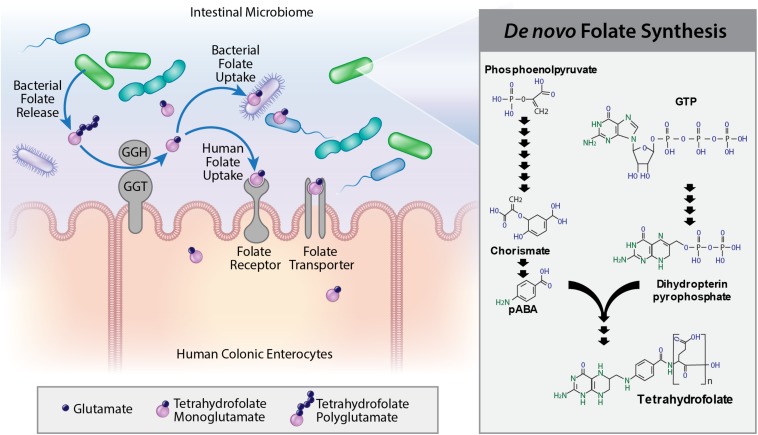
Model of microbial folate production and microbe:host interactions. Polyglutamylated tetrahydrofolates are synthesized by the human intestinal microbiome. Human gamma-glutamylhydrolase, GGH, and gamma-glutamyltransferase, GGT, remove glutamate moieties making monoglutamylated folates available for uptake by other luminal bacteria or human colonocytes. Folate can activate folate receptors (Frα or Frβ) or be taken up into enterocytes by folate transporters (RFC or PCFT).